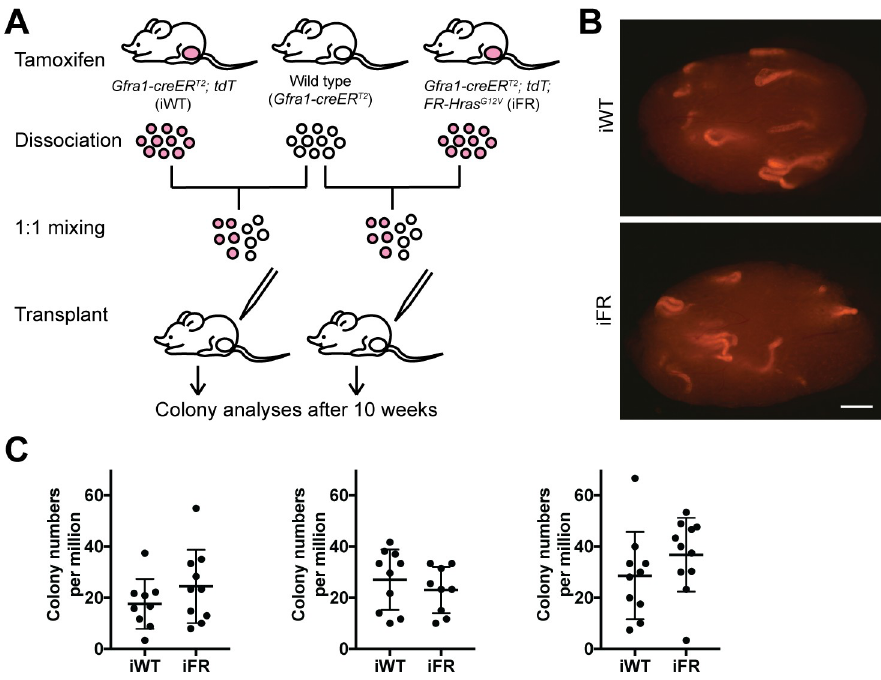
Fig 5. Comparable stem cell capacity in wild-type and Hras G12V -positive undifferentiated spermatogonia revealed by competitive transplant assay. A. Experimental strategy for competitive transplantation. WT and FR littermates received two 4-day courses of tamoxifen. Two weeks after treatment, testicular cell suspensions from individual iWT, iFR, and non-labeled WT mice were prepared, mixed, and transplanted into sterile recipients. Colony numbers were counted after 10 weeks. B. Representative whole mount stereomicrographs from iWT and iFR transplants after 10 weeks. Scale bar: 1 mm. C. Colony numbers from three independent competitive transplant assays. Colony numbers were similar between iWT and iFR. Each assay used one pair of littermates. T-test (two-tailed, equal variance) was done to compare iWT and iFR (For each experiment, P = 0.25, 0.42, and 0.25, respectively).